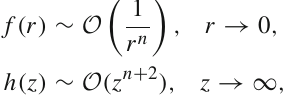
Fig. 4 The left panel shows the causal horizon entropy for z (cid:12) 1 (UV behavior), while the right panel for z (cid:13) 1 (IR behavior). The horizon- tal axes of both panels represent the affine parameter λ . We have set